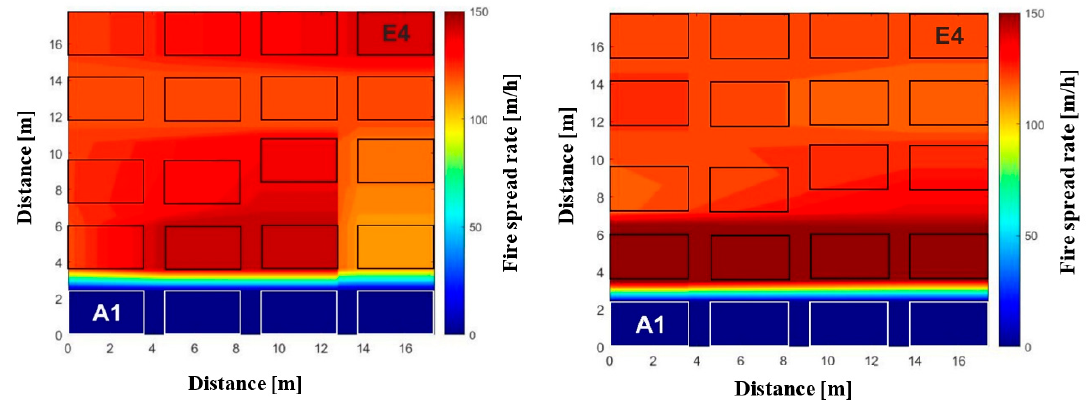
Figure 12. ( a ) Colour map depicting the fire line progression rate relative to time zero, and the pattern of the 20-dwelling experiment, where dwellings A1 to A4 are ignited. ( b ) Colour map depicting the fire line progression rate relative to time zero, and the pattern of the baseline simulations, where dwellings A1 to A4 are ignited.